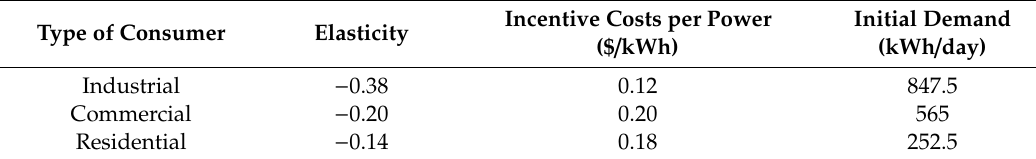
Table 3. Wind turbine data and Weibull probability density function (PDF) factor.